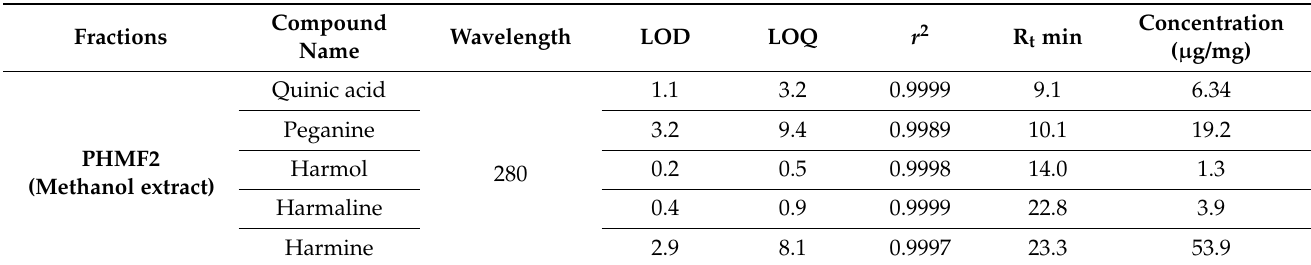
Figure 8. HPLC chromatogram of the PHMF2 subfraction at 280 nm. (1) quinic acid, (2) peganine, (3) harmol, (4) harmaline, and (5) harmine. Figure 9. HPLC overlay chromatogram of the mixture of external standards and PHMF2 at 280 nm.